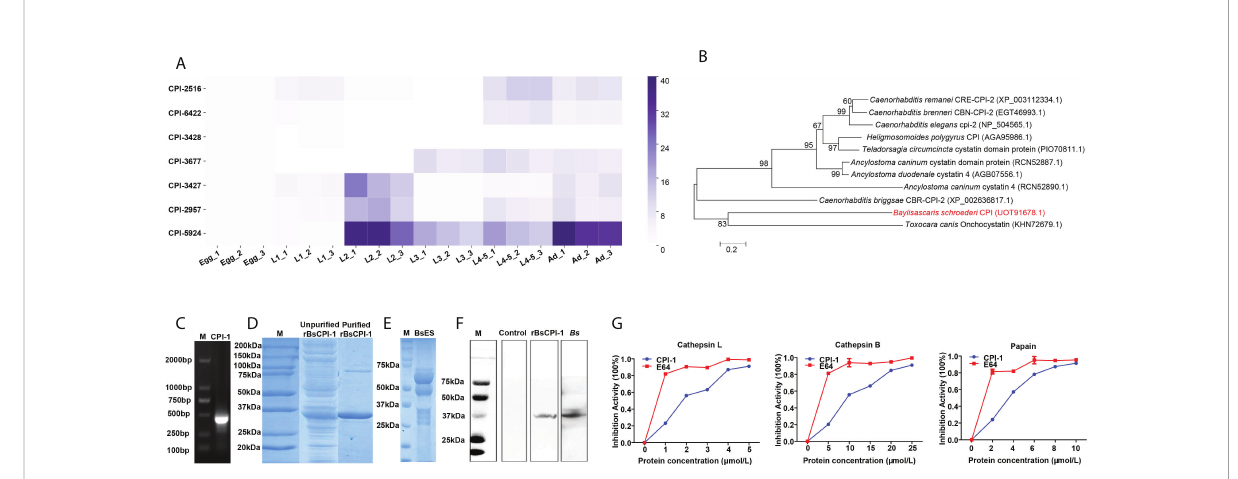
FIGURE 1 Analysis of the expression and inhibitory activity of rBsCPI-1. (A) The relative expression of 7 BsCPIs in B. schroederi at different stages was detected by qPCR. (B) Phylogenetic tree of CPIs in 11 organisms produced through the ML and NJ method (the red font represents BsCPI-1). (C) Ampli fi cation of the target band from L2 larval cDNA. M, marker. (D) SDS-PAGE gel showing rBsCPI-1. M, protein marker. (E) SDS-PAGE gel showing L2 larval ES antigens. M, protein marker; BsES, L2 larval ES proteins. (F) Western blot analysis of rBsCPI-1. M, protein marker; rBsCPI-1 was found among L2 larval ES proteins upon probing with anti-rBsCPI-1 serum (rBsCPI-1) but not upon probing with negative (control) serum; and rBsCPI-1 antigen was recognized by mouse serum infected by B. schroederi (Bs). (G) The inhibitory activity of rBsCPI-1 against CatL, CatB and papain was detected. The activity of the noninhibited enzyme (incubated with 0 m mol/mL rBsCPI-1) was taken as 100% activity (inhibitory activity: 0%). The data are shown as the mean ± SD of 3 repetitions per